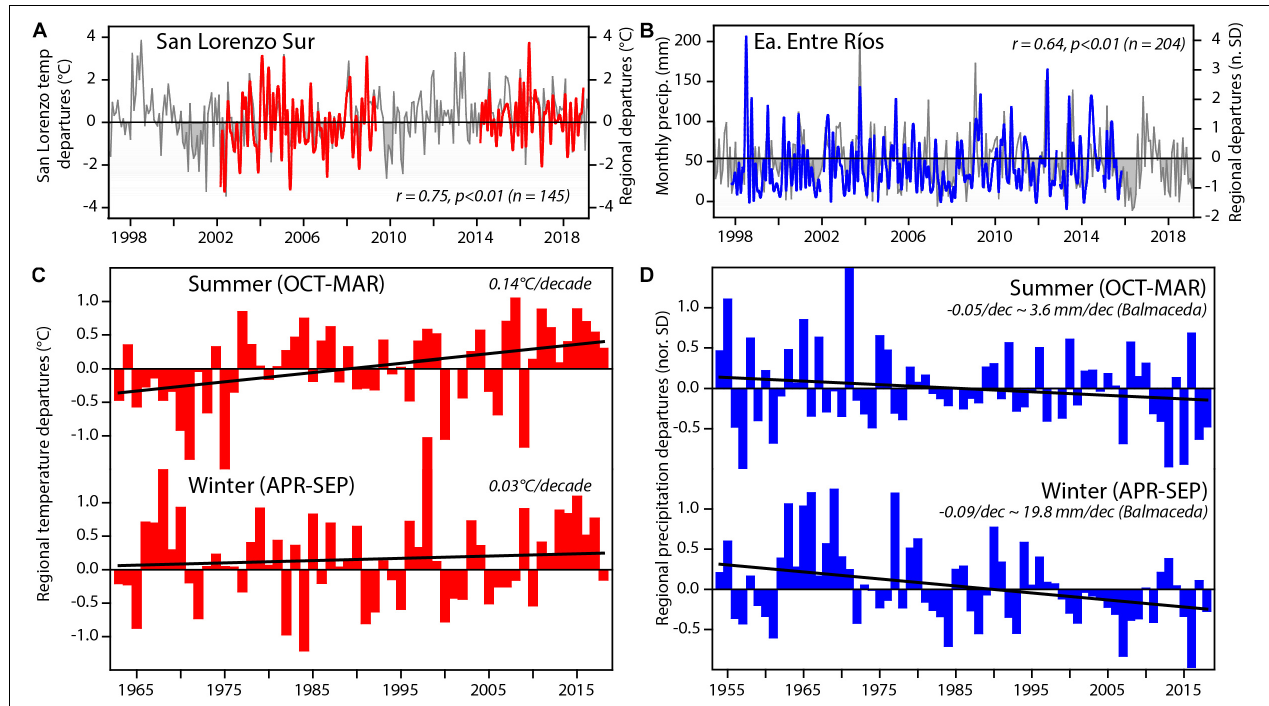
FIGURE 6 | Monthly temperature (A) and precipitation (B) deviations for San Lorenzo Sur (red) and EER (blue) compared to the regional records based on Balmaceda and Cochrane meterorological stations. (C,D ) Shows the seasonal (austral summer and winter) monthly temperature (1963–2018) and precipitation (1954–2018) regional departures, respectively. See main text for